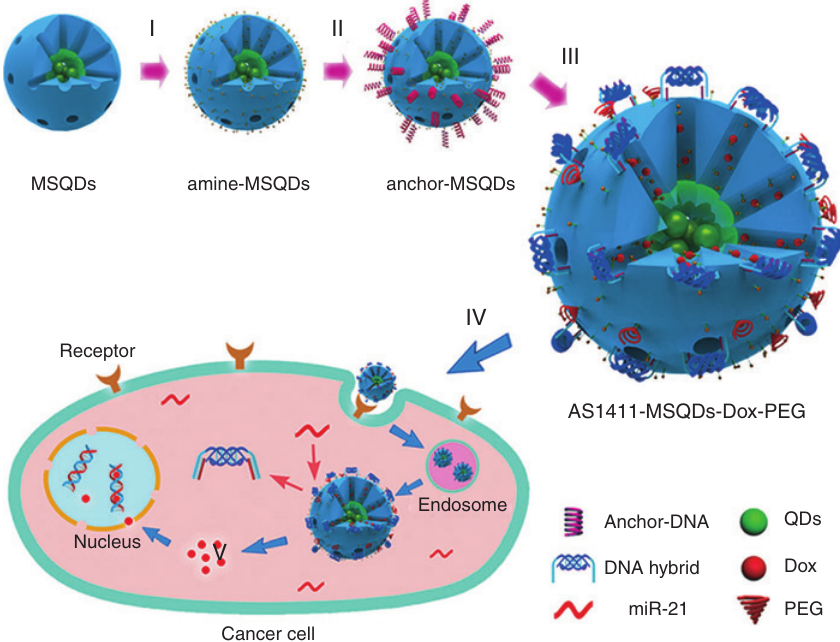
Figure 5: Preparation and application of miRNA-responsive controlled drug delivery nanocarriers. Reprinted with permission of Ref. [61]. © Copyright 2014 Wiley-VCH Verlag GmbH & Co.